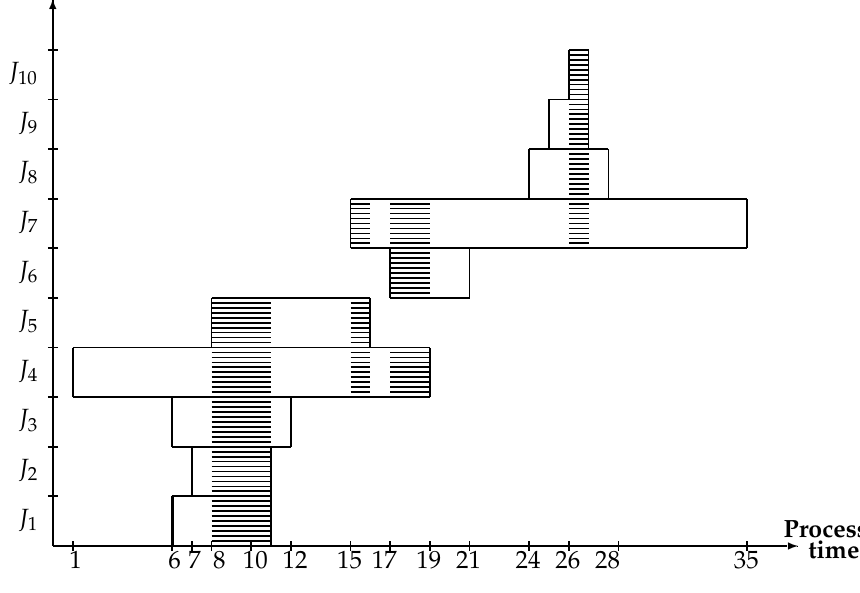
] given for the feasible processing times of the jobs J , p U i i